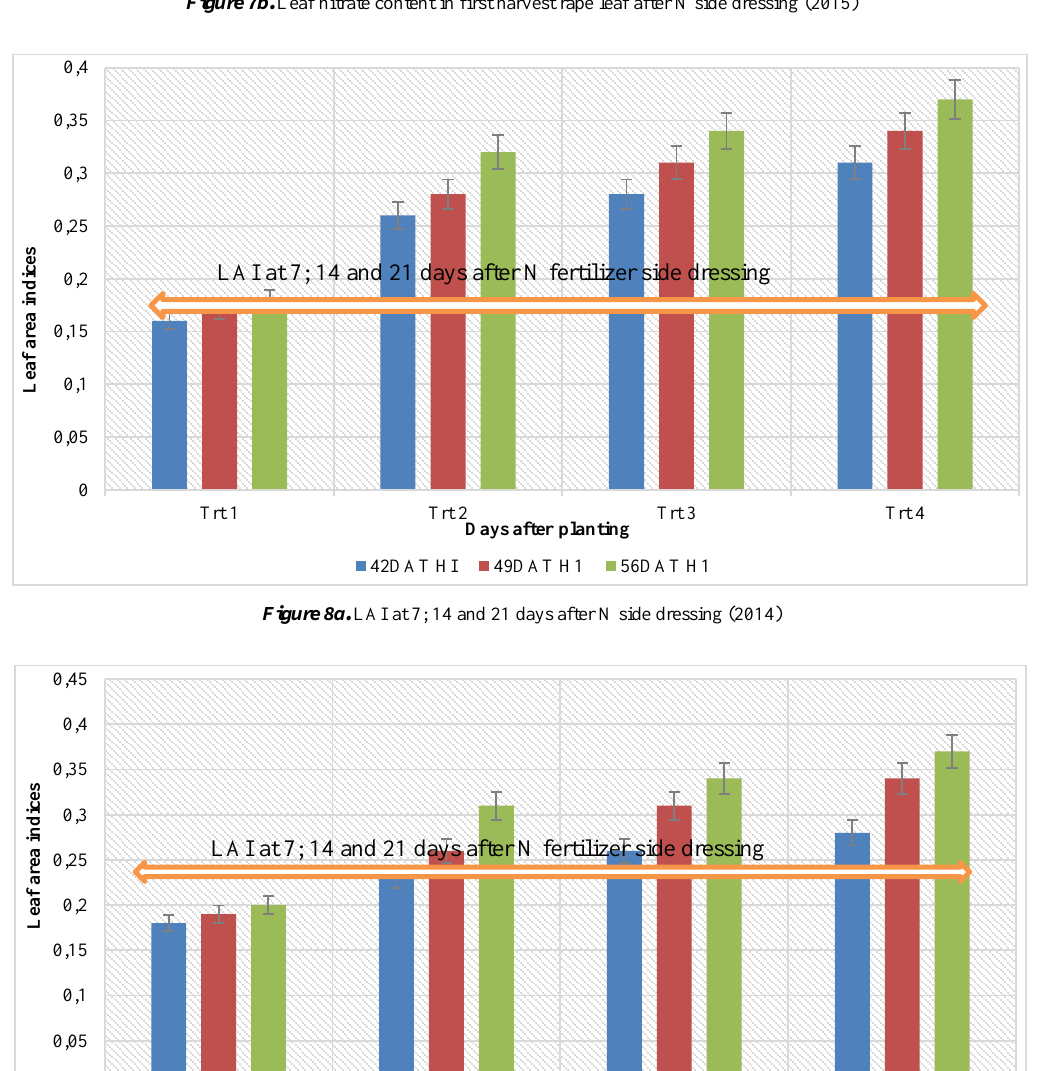
Figure 7b. Leaf nitrate content in first harvest rape leaf after N side dressing (2015)